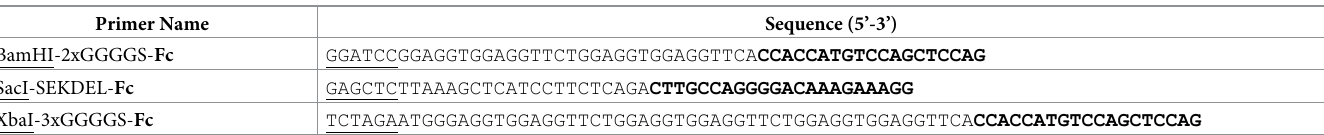
Table 1. List of primers used in this